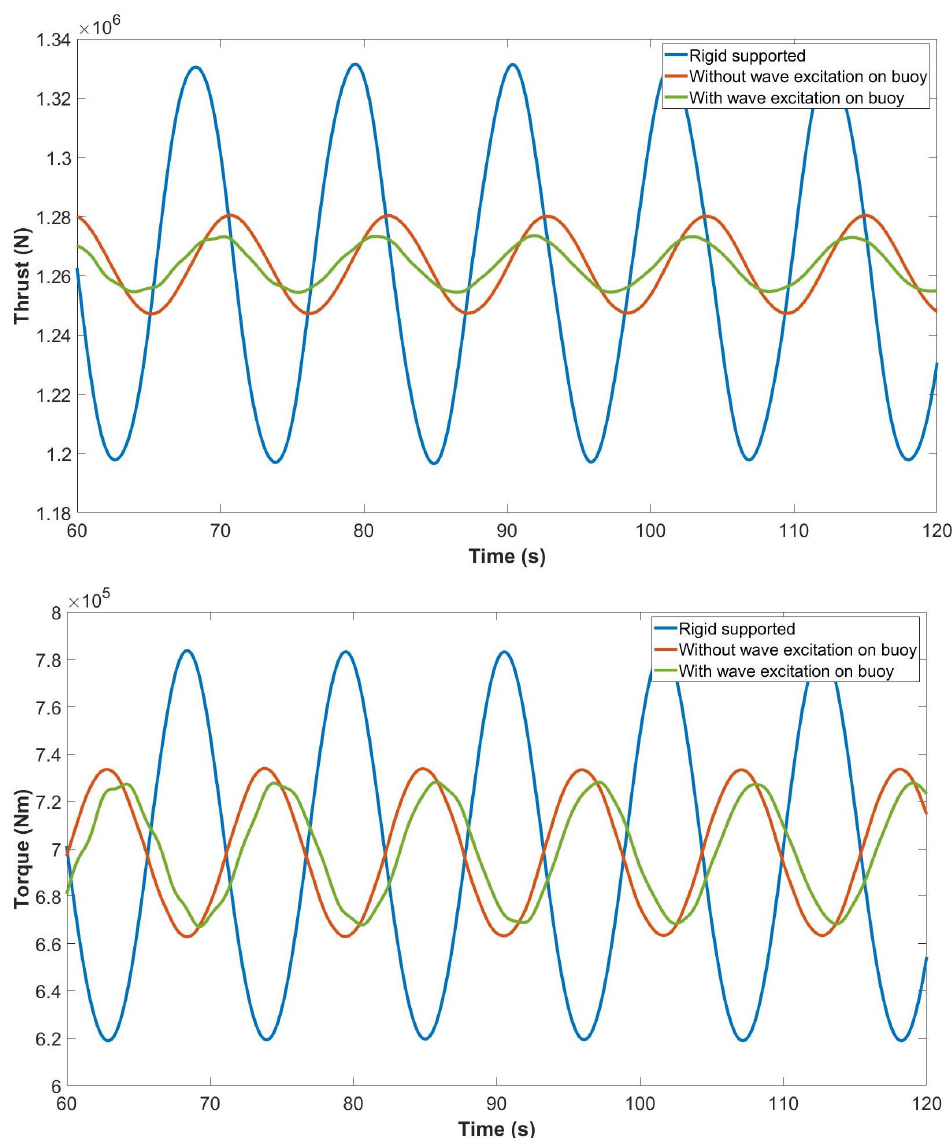
Figure 8. Thrust and torque in sea state